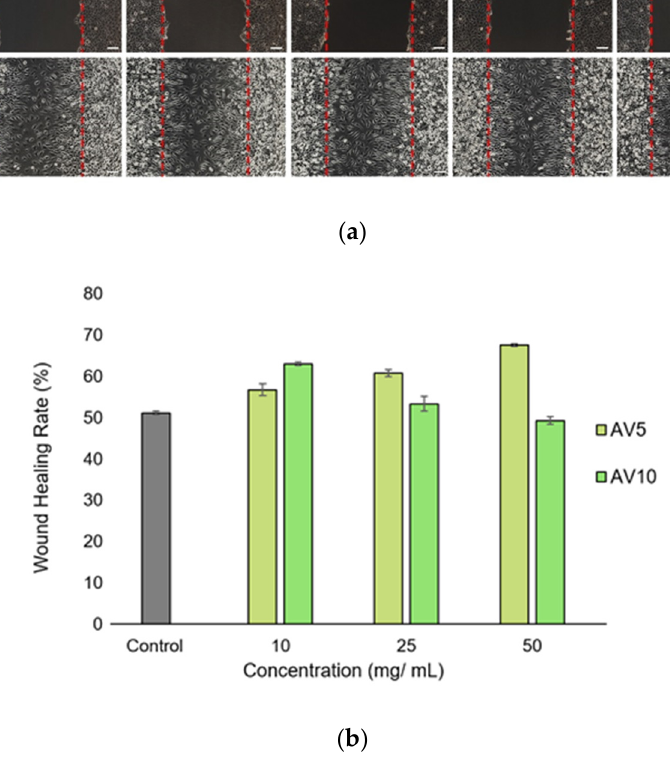
Figure 7. Light microscope images of the L929 cell monolayer ( a ) after in vitro generation of a wound and treatment with different concentrations (10, 25 and 50 mg/mL) of AV5 and AV10 hydrogels, for 24 h. The cell migration in the injured area could be observed. Upper line—t = 0, lower line—after 24 h of treatment. Control was represented by untreated cells. The percentage of wound closure for L929 ( b ) was determined by ImageJ analysis. Data were expressed as mean values ± SD (n = 3).